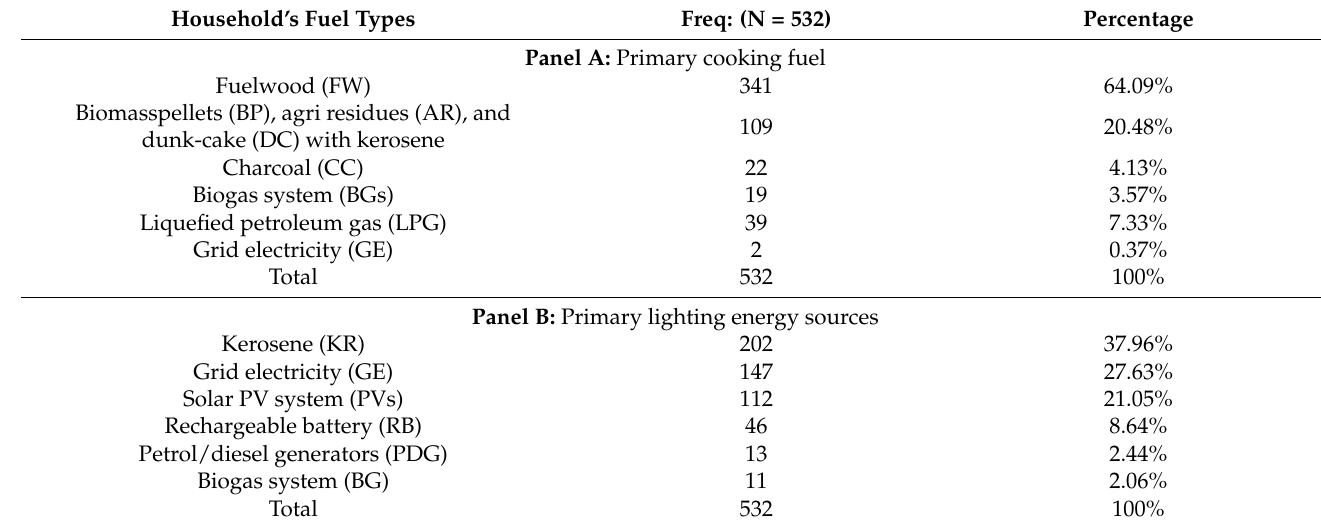
Table 3. Primary cooking and lighting energy choices.